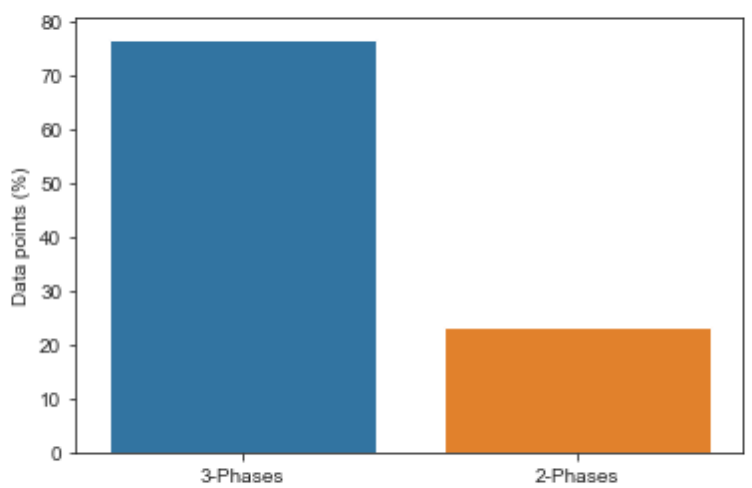
Figure 16. Distribution of Three Phase (liquid–liquid–vapor) and Two Phase (Liquid–vapor) Data Available.